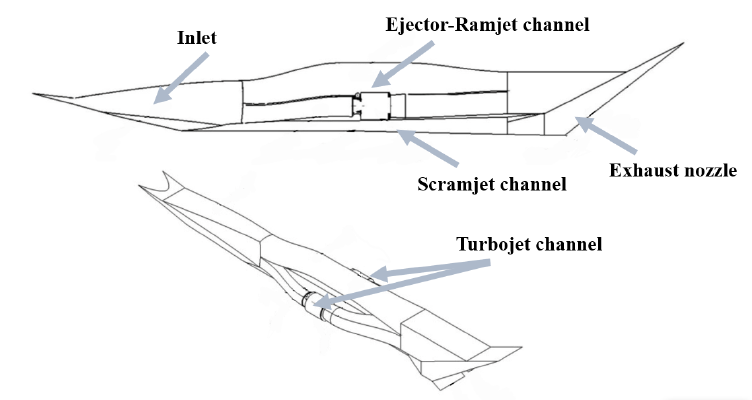
Figure 1. Structural diagram of XTER.